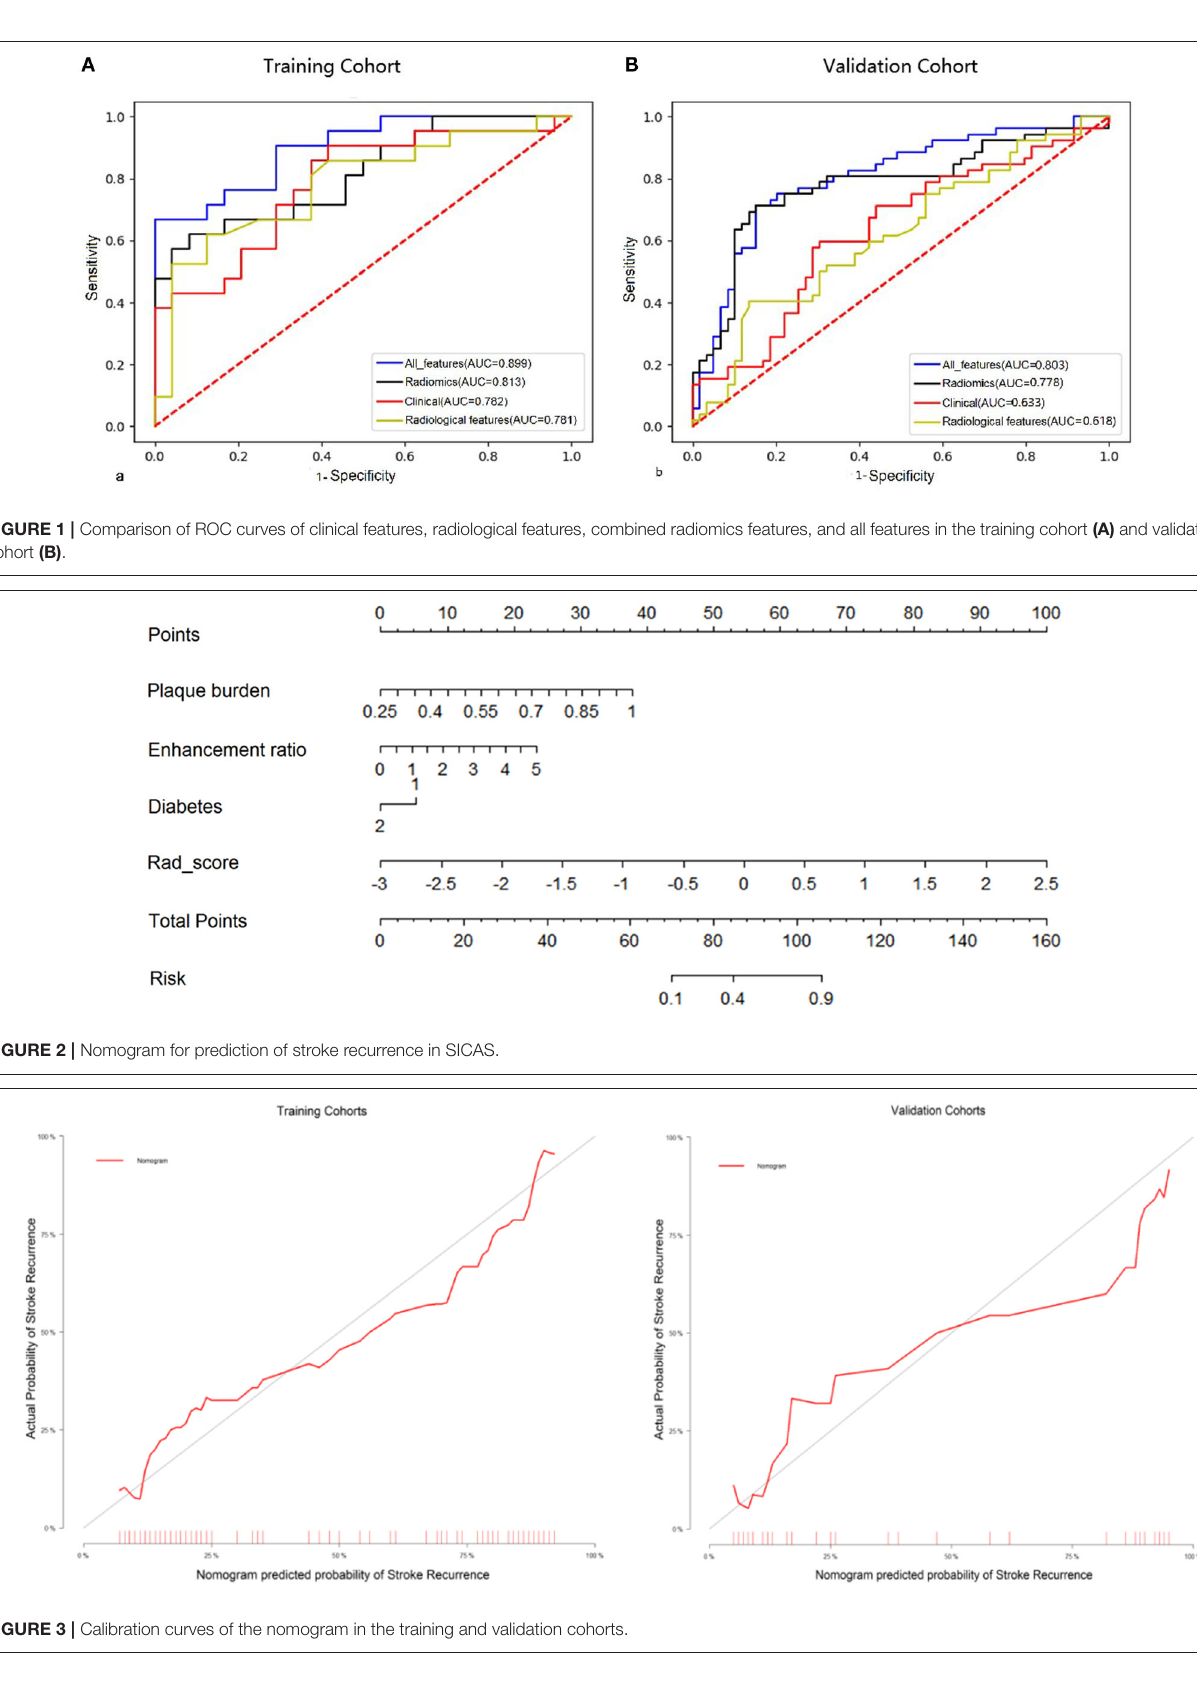
Frontiers in Neuroscience |